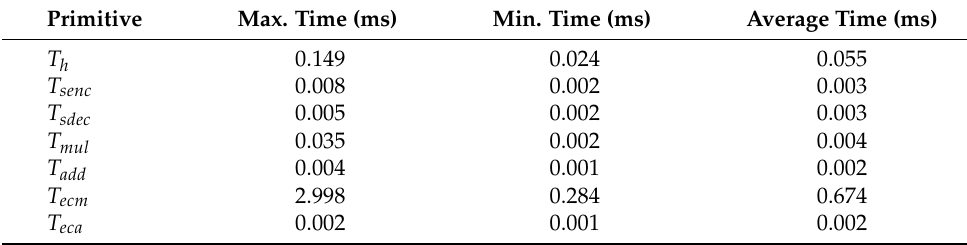
Table 2. Execution time (in milliseconds) of cryptographic primitives under a server setting. Primitive Max. Time (ms) Min. Time (ms) Average Time (ms) T